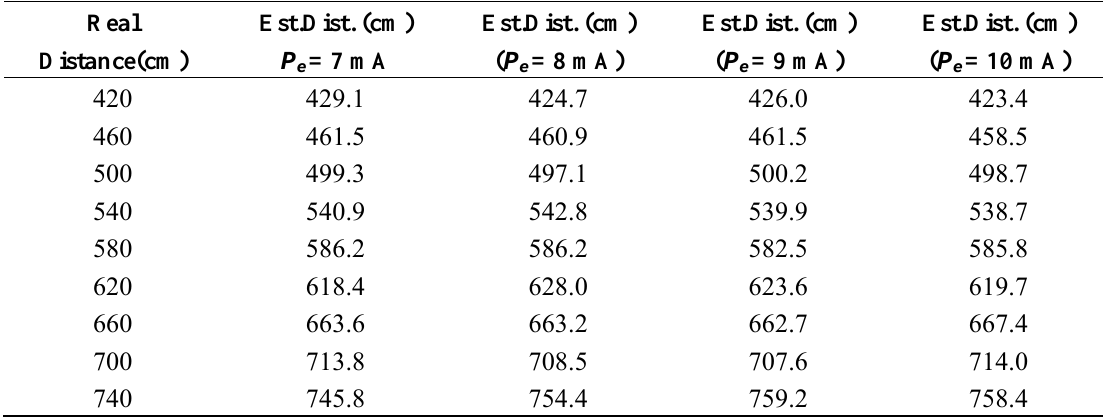
Table 3. Relative error on distance estimation for the first experiment.